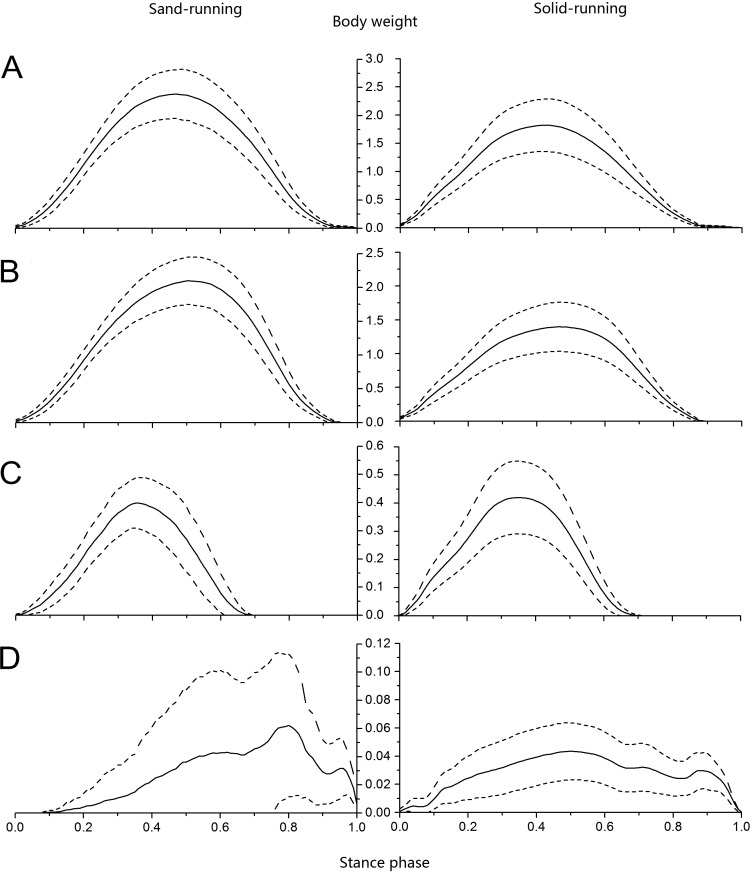
Vertical ground reaction forces versus stance phase during loose sand and solid ground running trials.Vertical ground reaction forces of (A) total foot, (B) 3rd toe, (C) 4th toe, and (D) the claw were all normalized against the body weight. The solid lines and dotted lines stand for the mean and standard deviations, respectively (the same below).